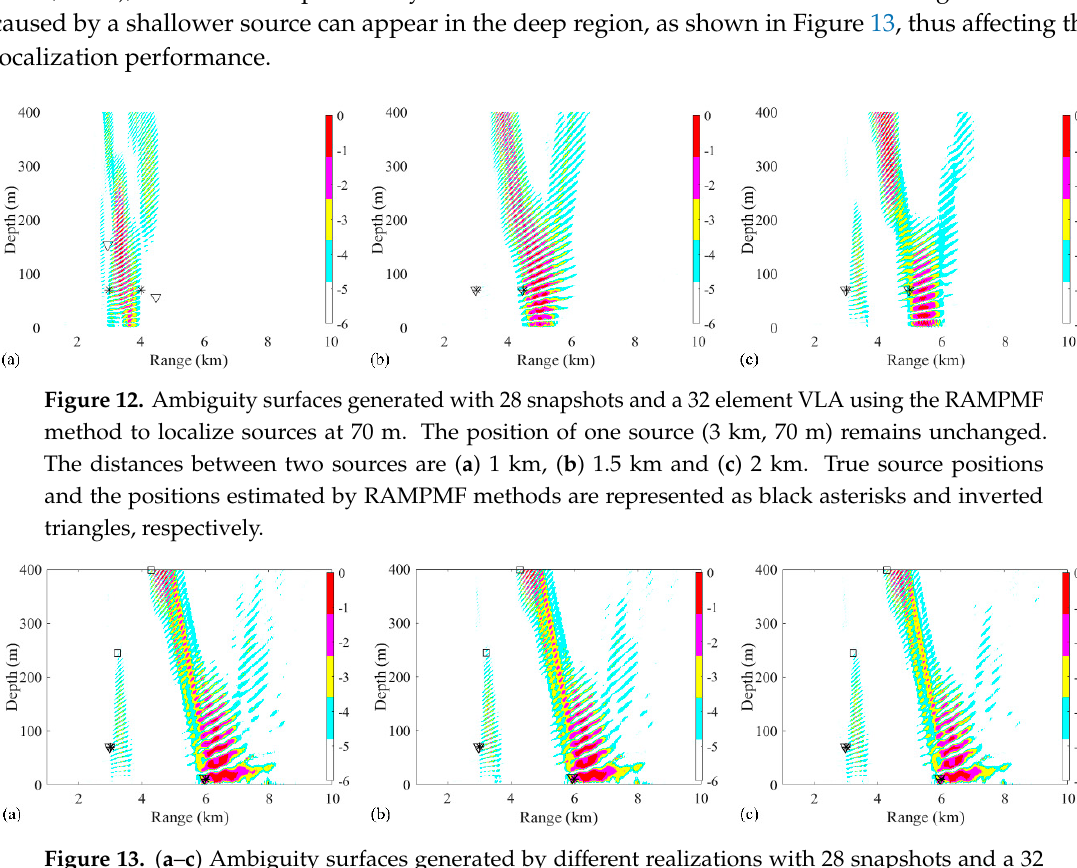
Figure 13. ( a , b,c ) Ambiguity surfaces generated by different realizations with 28 snapshots and a 32 element VLA using the RAMPMF method to localize sources (3 km, 70 m) and (6 km, 10 m). True source positions and the positions estimated by the RAMP and RAMPMF methods are represented as black asterisks, squares, and inverted triangles, respectively.